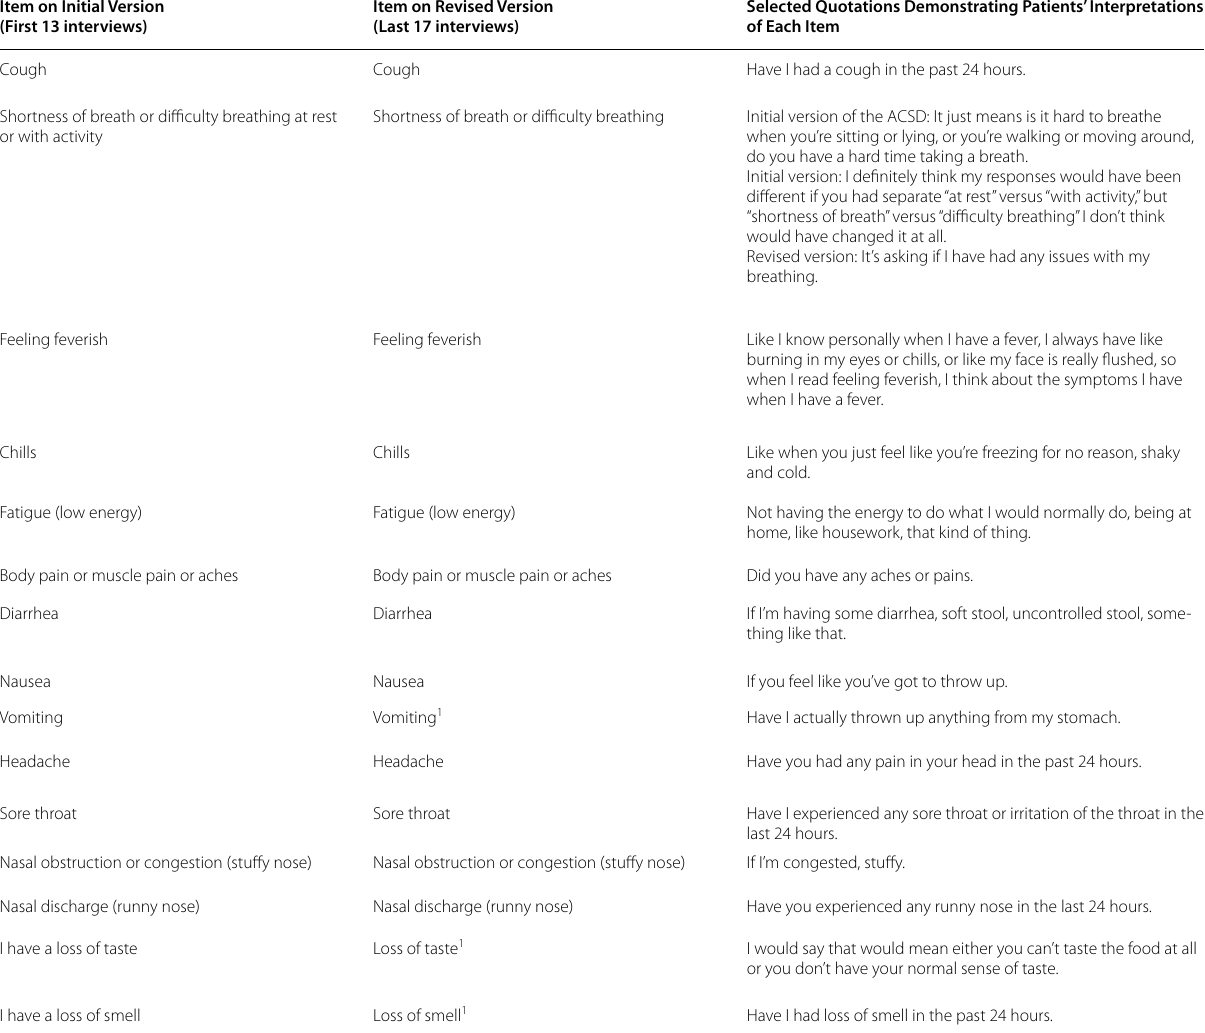
1 Four changes to the ACSD are recommended for future research: dropping the item assessing vomiting, adding items assessing brain fog and dizziness, and using 4-point response scales (i.e., absent, mild, moderate, severe) for loss of taste and smell rather than dichotomous responses (i.e., yes, no)